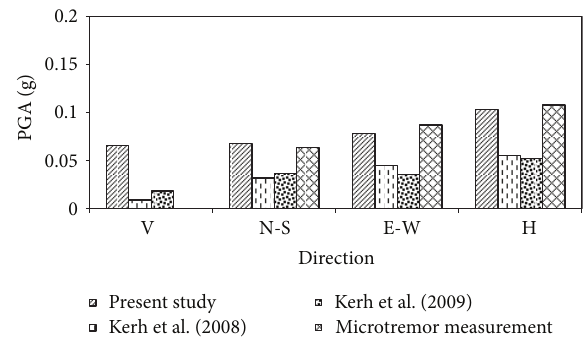
Figure 7: Predicted PGA results versus PGA results from microt- remor measurements.